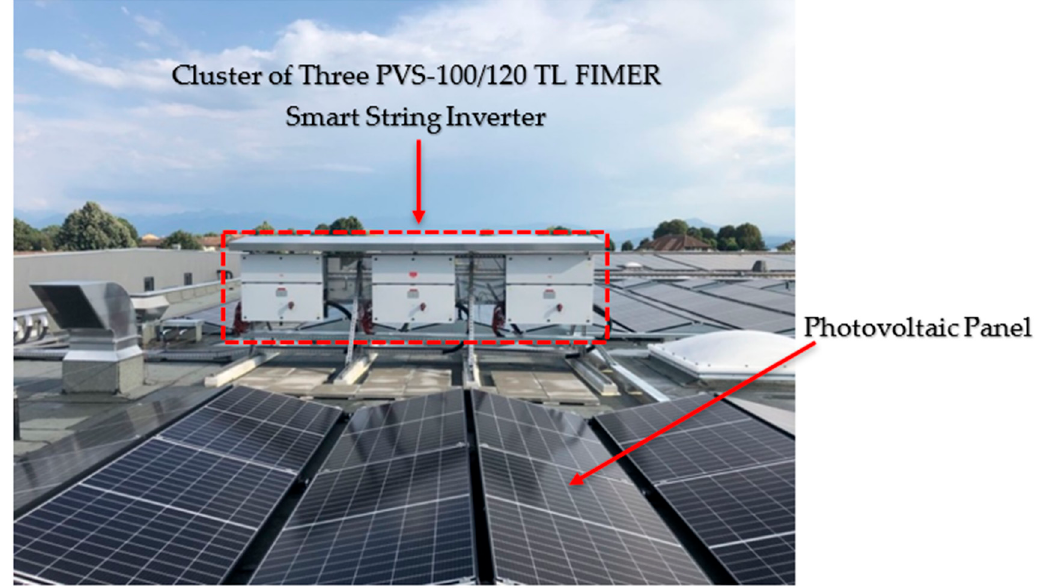
Figure 1. Photovoltaic (PV) installation of 280 KiloWatts (KW) featuring a cluster of three PVS-100/120-TL FIMER smart string inverters between Geneva and Lausanne, Switzerland. Photo courtesy of KDISOLAR.